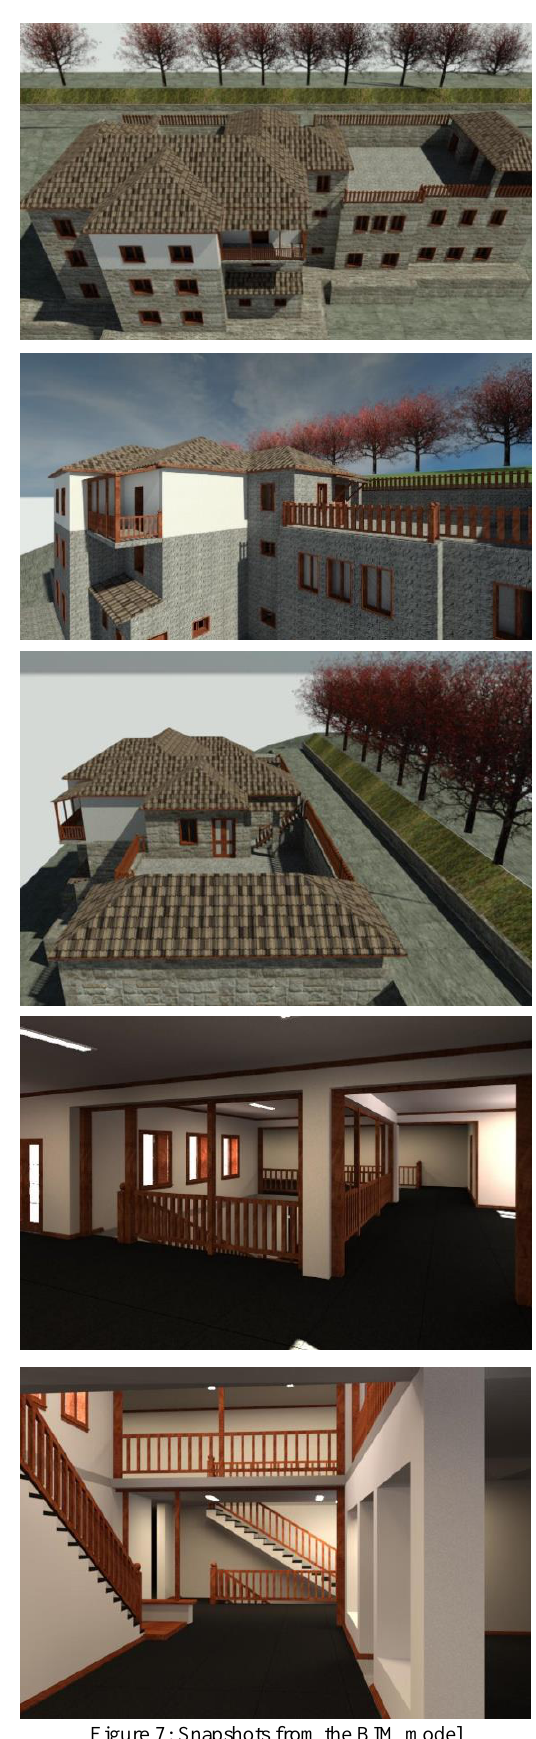
Figure 7: Snapshots from the BIM